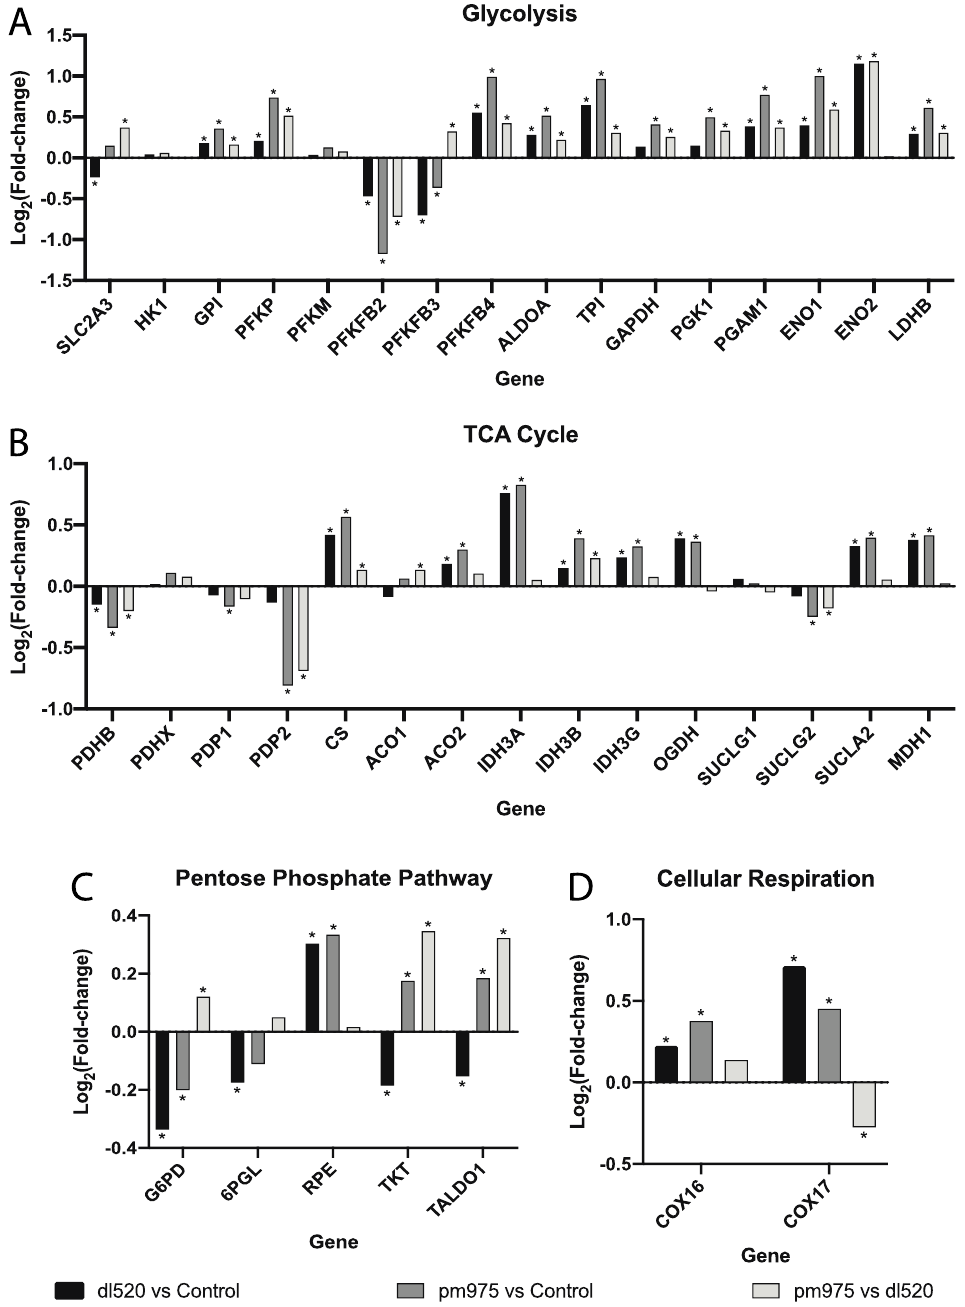
Figure 6. RNAseq analysis of metabolic genes from IMR-90 lung fibroblasts infected with either dl520 , pm975 or an E1A-deleted HAdV-5 control virus. ( A ) RNA expression of glycolytic enzyme-encoding transcripts was often greater in pm975 infected cells than dl520 infected cells. However, dl520 infected cells also expressed glycolytic genes at consistently higher levels than in an E1A-deleted control HAdV-5 infection. ( B ) RNA expression of transcripts encoding TCA cycle enzymes, more highly up- or downregulated in pm975 infected cells when compared to dl520 infected cells. ( C ) Transcripts